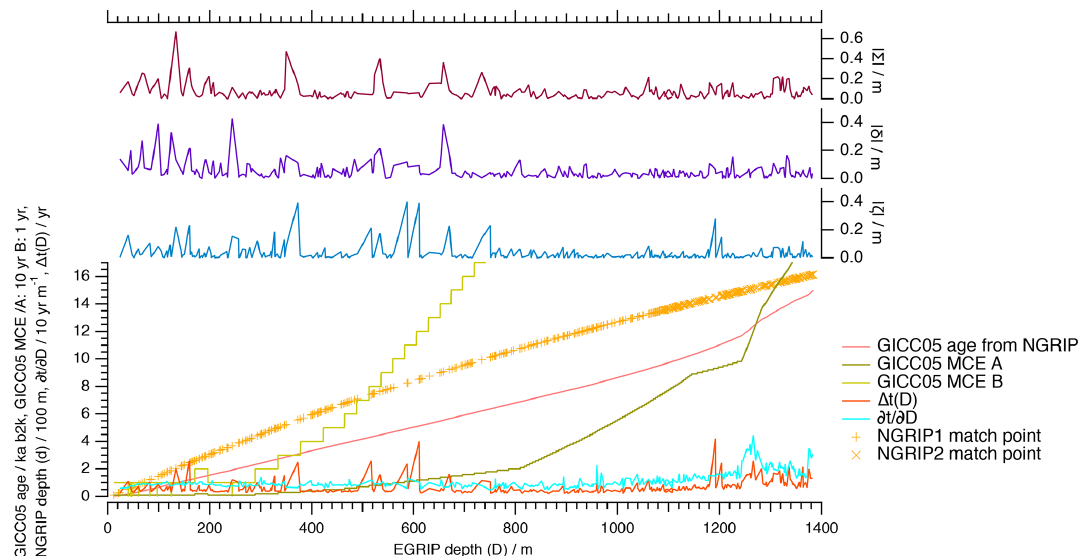
Figure E2. The (EGRIP, NGRIP) match points, the (EGRIP depth, GICC05 time) scale, the (EGRIP depth, GICC05 MCE) curve, | δ | , | (cid:54) | , (cid:12) (cid:12) ∂t (cid:12) (cid:12)(cid:112) ( (cid:49)t ) 2 + ζ 2 . (cid:12) | ζ | , ∂t GICC05 , (cid:49)t ( D ) = (cid:12) ∂D EGRIP ∂D